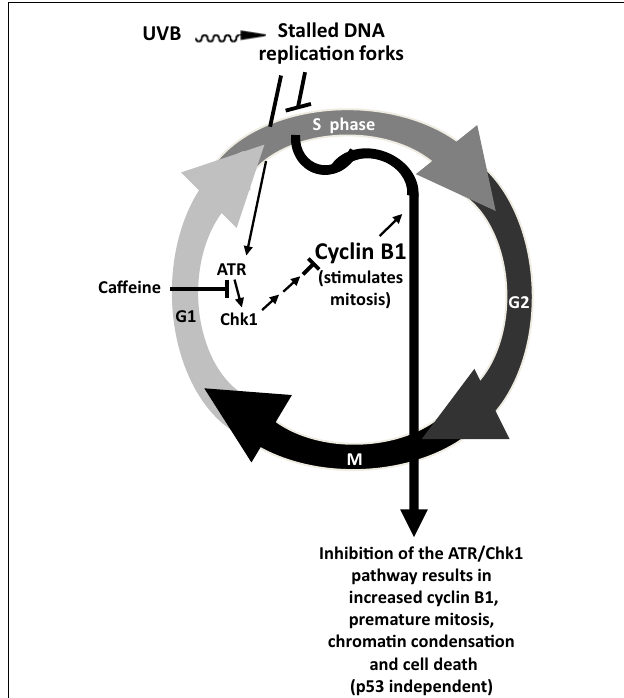
FIGURE 5 | Proposed effects of UVB and caffeine on the ATR/Chk1/cyclin B1 pathway and premature mitosis .The signal that DNA synthesis is not complete (and that chromatin condensation and mitosis should not start) after UVB irradiation is sent by ATR after it is recruited to stalled replication forks that have been coated by replication protein A. ATR-mediated phosphorylation of Chk1 after UVB irradiation results in a decreased level and function of cyclin B1, which delays mitotic entry and prevents premature chromatin condensation and mitosis. Inhibition of the ATR/Chk1 pathway in UVB-treated cells should result in a premature increase in cyclin B1 and premature chromatin condensation, mitosis, and cell death, probably by mitotic catastrophe followed by apoptosis, as suggested by Brown and Attardi (2005). Adapted with permission from Nghiem et al. (2001)Taken from Lu et al. (2008).